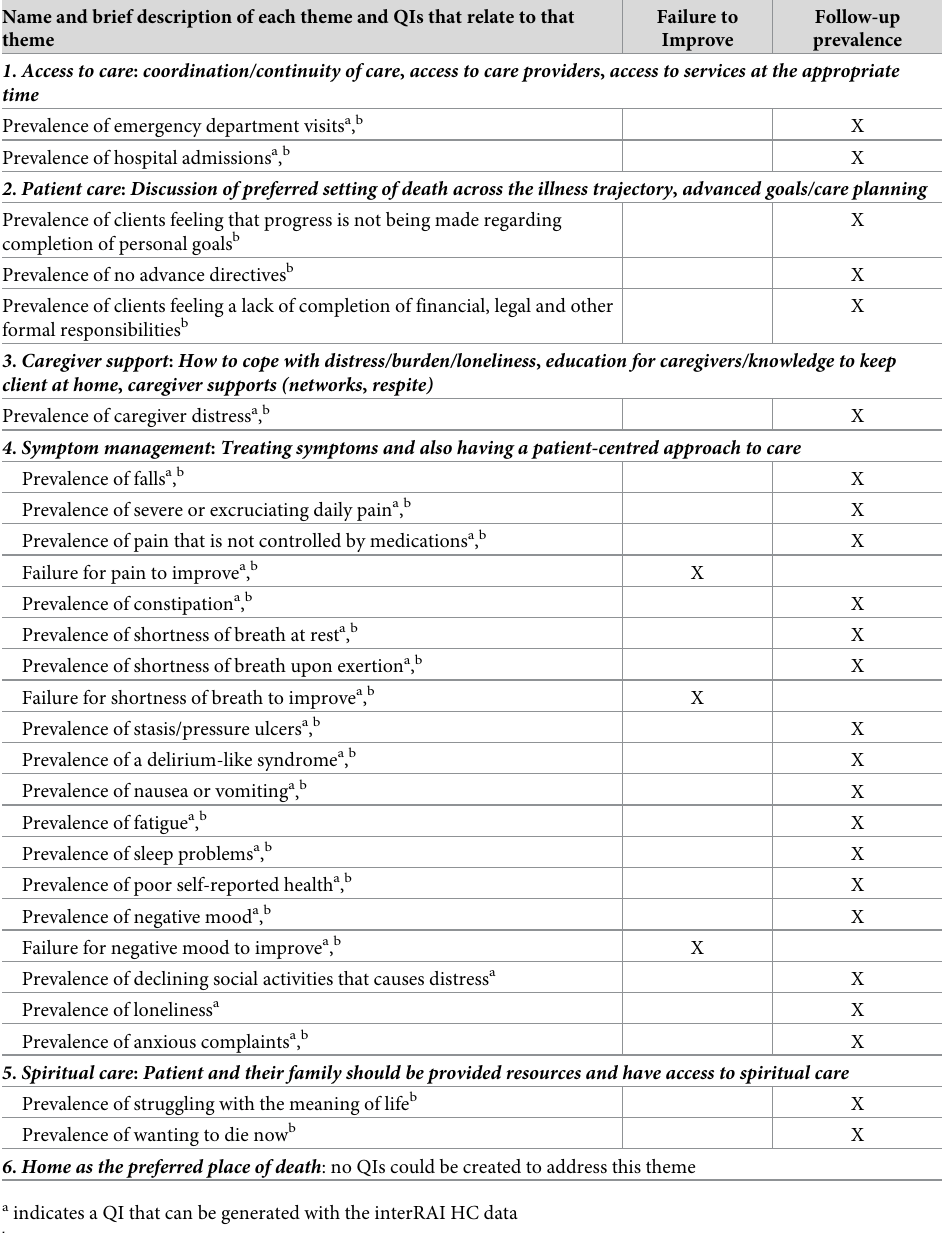
Table 1. List of the 27 preliminary QIs reviewed by the expert panel, how they relate to the 6 themes identified in Phase I and which interRAI assessment can be used to generate the QI. Name and brief description of each theme and QIs that relate to that theme